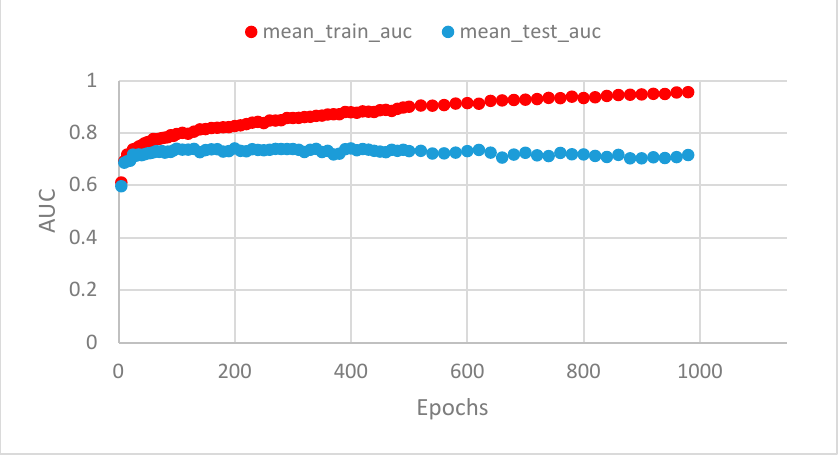
Figure 2. Training epoch with AUCs. It is not possible to completely eliminate overfitting in deep learning, but there are known hyperparameters of deep learning that can be adjusted to reduce the effect of over- fitting [16]. As mentioned previously, “epochs”, a hyperparameter that helps balance